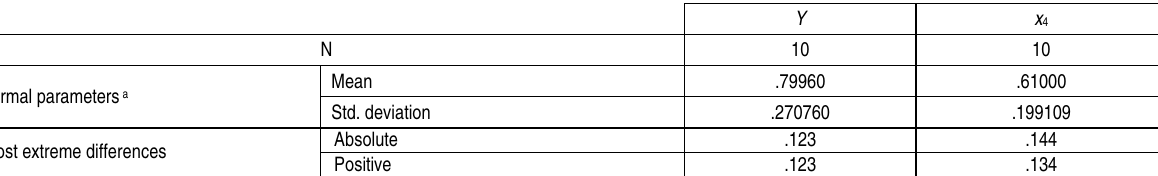
Table 16. The fourth hypothesis test result (normality test and correlation